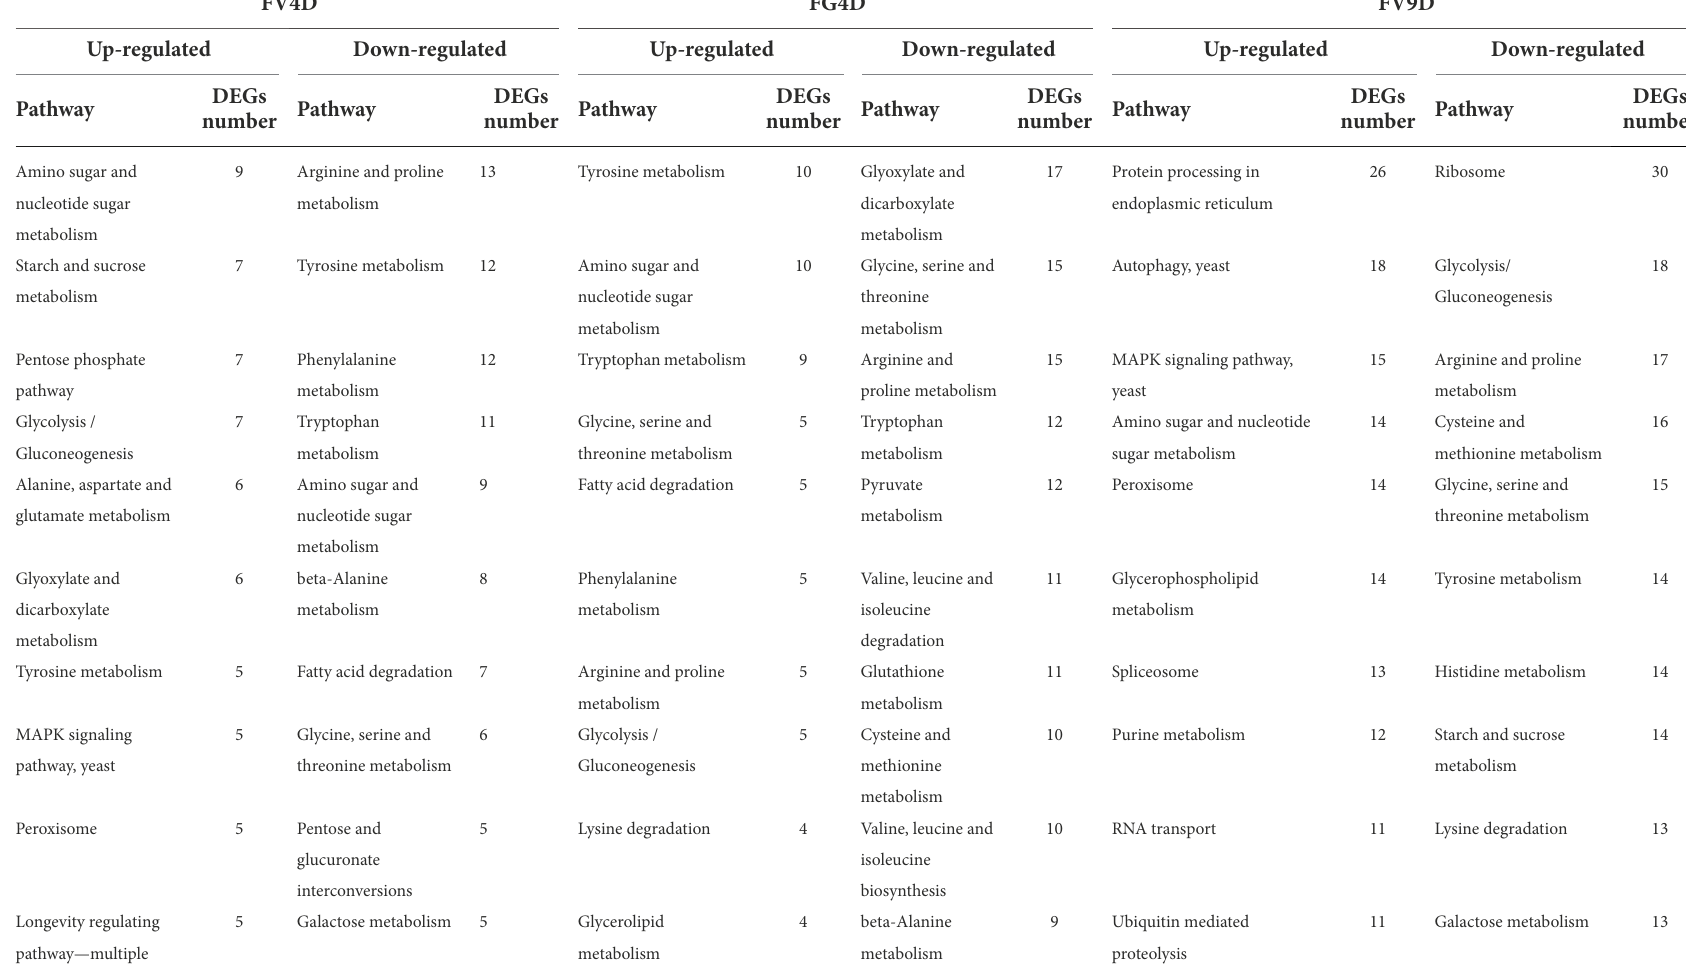
FV4D: DEGs by comparing samples of Fusarium verticillioides cultivated for 4 days at 20 ° C with samples of F. verticillioides cultivated for 4 days at 30 ° C, FG4D: DEGs by comparing samples of Fusarium graminearum cultivated for 4 days at 20 ° C with samples of F. graminearum cultivated for 4 days at 30 ° C, FV9D: DEGs by comparing samples of F. verticillioides cultivated for 9 days at 20 ° C with samples of F. verticillioides cultivated for 9 days at 30 °